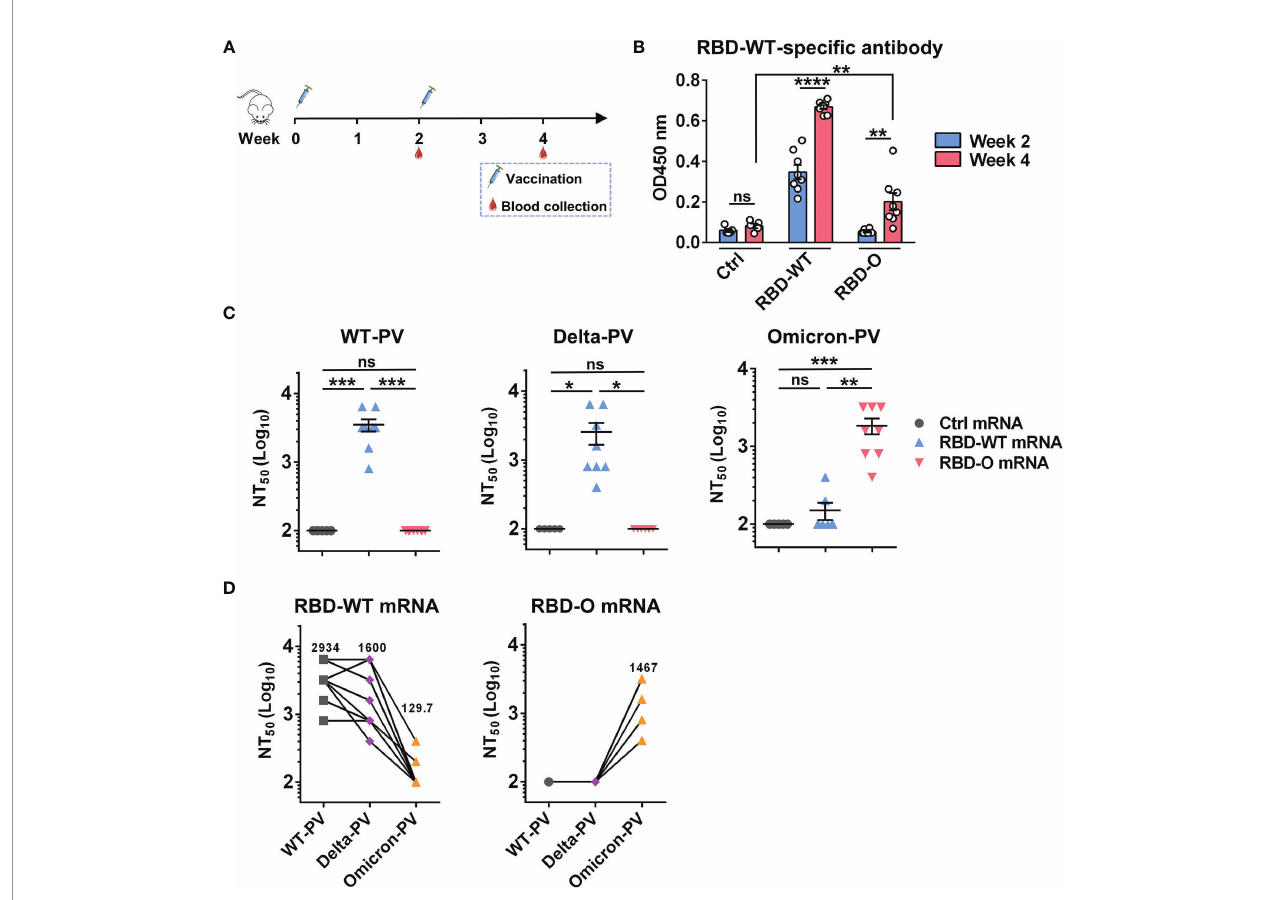
FIGURE 2 | Immunization with mRNA vaccines elicited neutralizing antibodies in mice. (A) Mice immunization schedule. Groups of BALB/c mice were injected i.m. with 10 m g of RBD-WT mRNA (n = 8), RBD-O mRNA (n = 8), or luciferase-mRNA (Ctrl; n = 5) vaccines at weeks 0 and 2. Serum samples were collected from individual mice at weeks 2 and 4. (B) The week-2 and week-4 antisera were diluted 1:100 and analyzed for RBD-WT-binding activity by ELISA. (C) Neutralizing titers of the week-4 antisera samples from each group against WT-, Delta-, and Omicron-PV (pseudovirus). Serum samples that exhibited less than 50% neutralization at the lowest serum dilution (1:200) were assigned a NT 50 value of 100 for statistical analysis. Each symbol represents one mouse. (D) Neutralizing titers of the week-4 antisera from RBD-WT mRNA group (left panel) and RBD-O mRNA group (right panel) against SARS-CoV-2 PV. The geometric mean of NT50 values was shown. For panels (B, C) , data are presented as mean ± SEM. p values were analyzed with unpaired t -test and indicated as follows: ns, not signi fi cant; * p < 0.05; ** p < 0.01; *** p < 0.001; **** p <